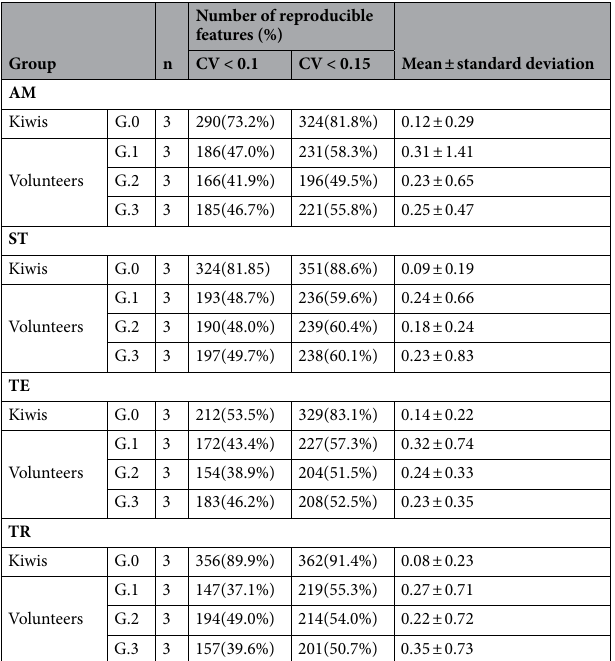
Table 2. The number of reproducible features for intra-MR analysis with different acquisition parameters for volunteers and kiwis out of a total of 396. TR repetition time; TE echo time; ST slice thickness; AM acquisition matrix; G.0 represents the three kiwis, while G.1–G.3 represent the three group volunteers in 6th–10th, 11th–15th, and16th–20th day of physiological cycle respectively; The values displayed on the table were means within each group. “Mean ± Standard Deviation” was calculated from mean CV values within each group. MR scanner: Philips Medical Systems (Ingenia 3.0 T, Philips Healthcare, Best, The